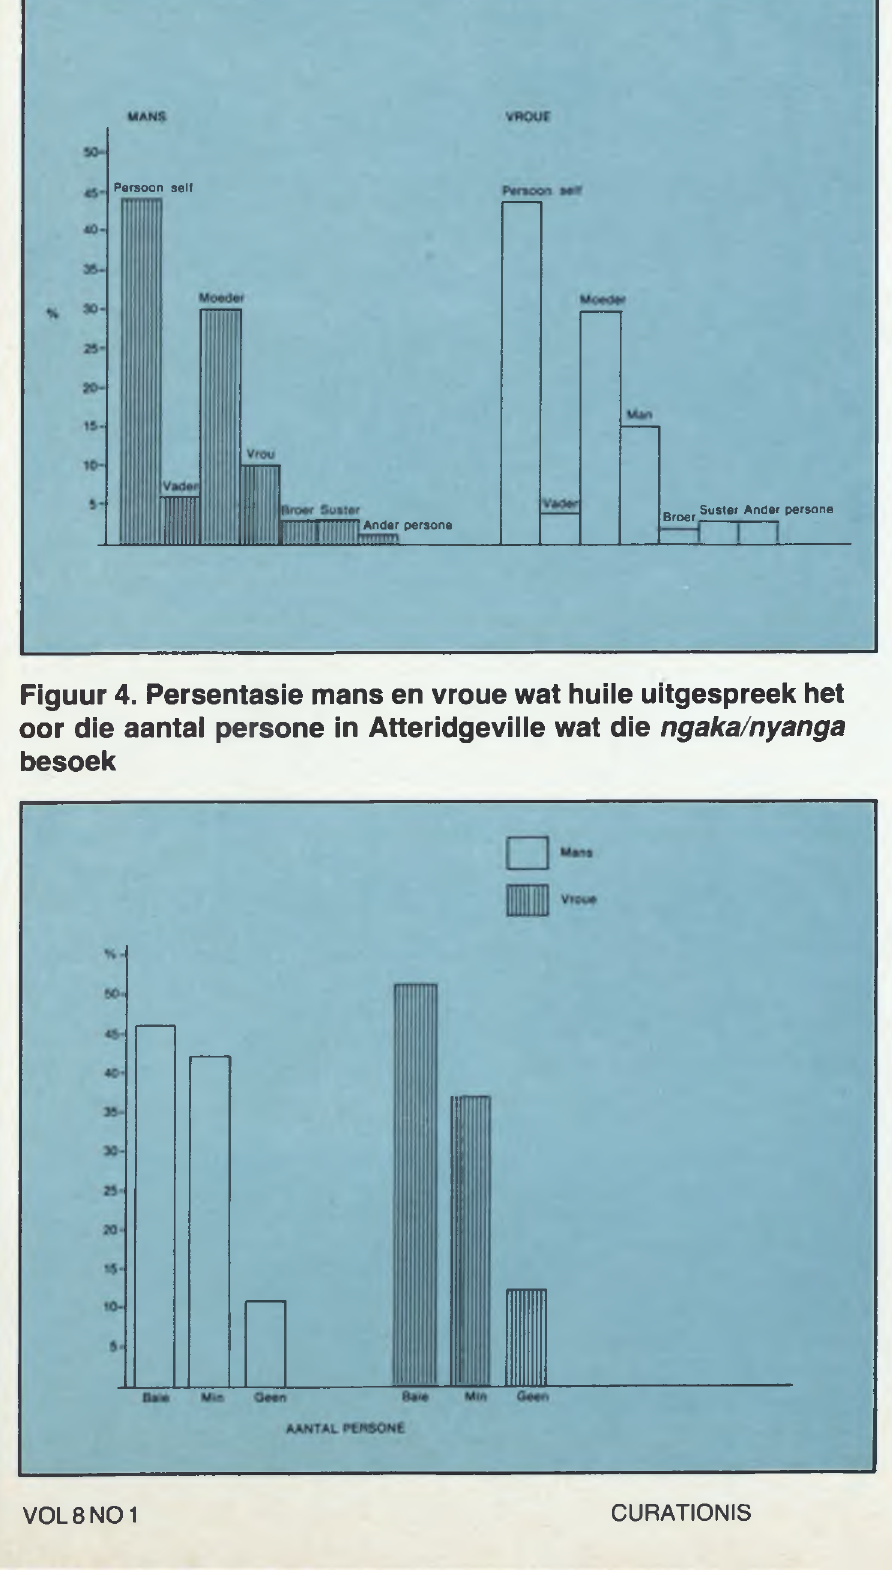
Figuur 3. Gesinslede wat geraadpleeg word oor gesondheids-